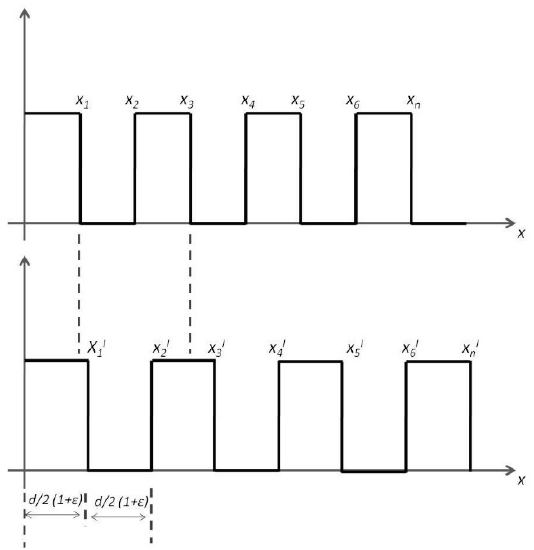
Figure 7. The distribution of white and black lines of the barcode before (on the ( top )) and after (on the ( bottom )) the deformation has taken place.